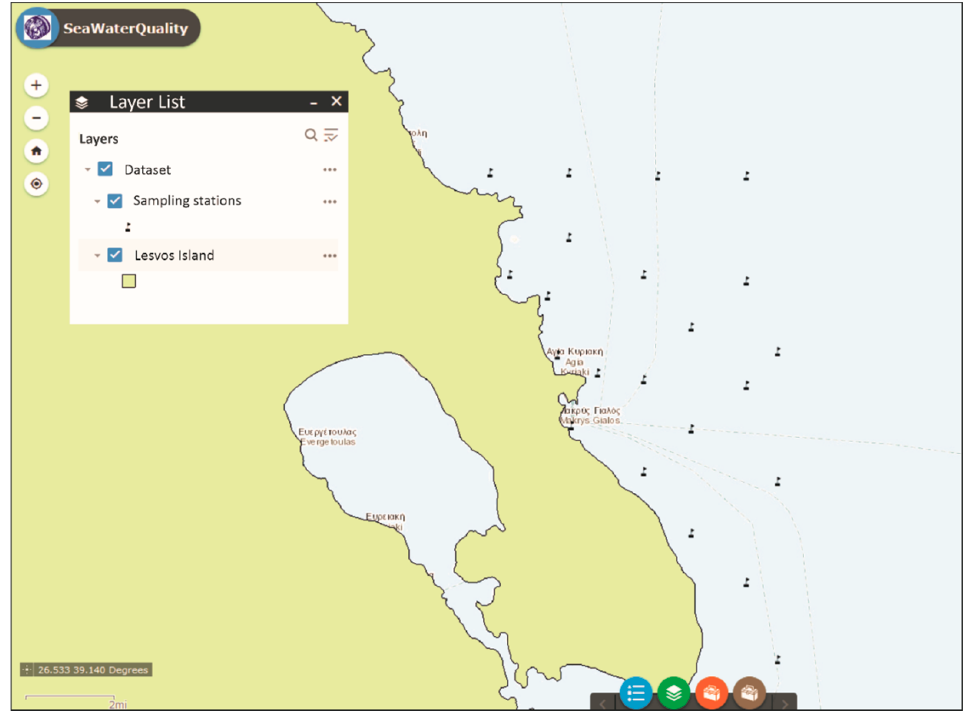
Figure 3. The user interface of the webGIS application (web link: https://wg-web1.aegean.gr/Sea- WaterQuality/).